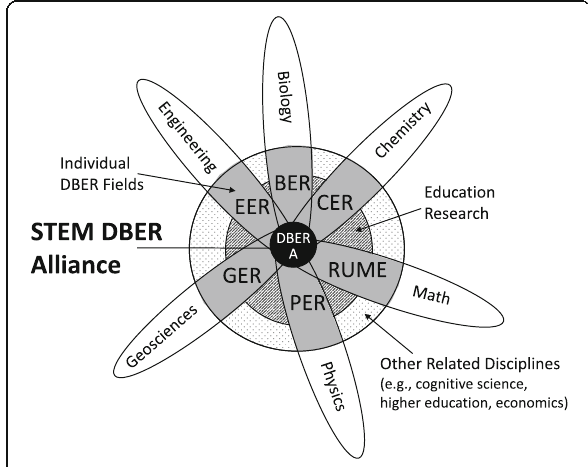
Fig. 2 The STEM DBER Alliance exists at the intersection of multiple DBER fields (image based on initial conceptualization by Mark